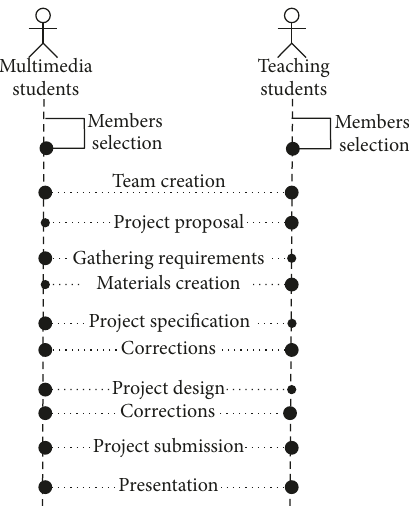
Figure 2: Coordination stages for interdisciplinary